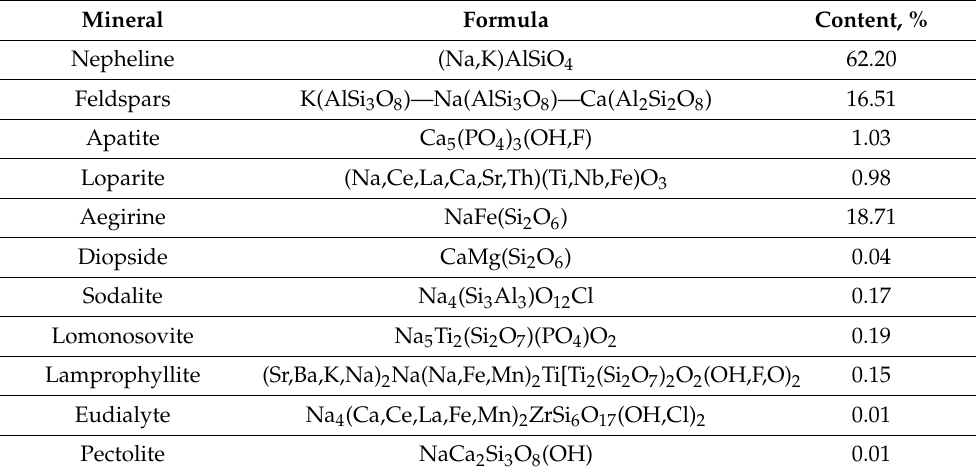
Table 2. Average mineral composition of the loparite ore concentration tailings. Mineral